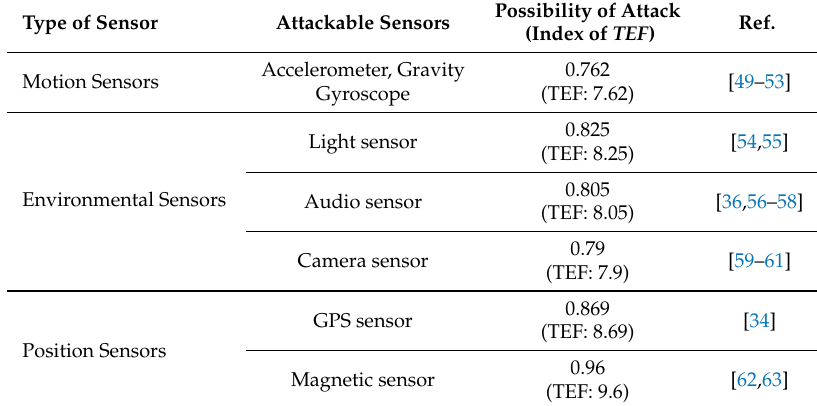
Table 3. This study sets TEF index as attack potential when an inference attack is performed through data collected by various sensors attached to IoT